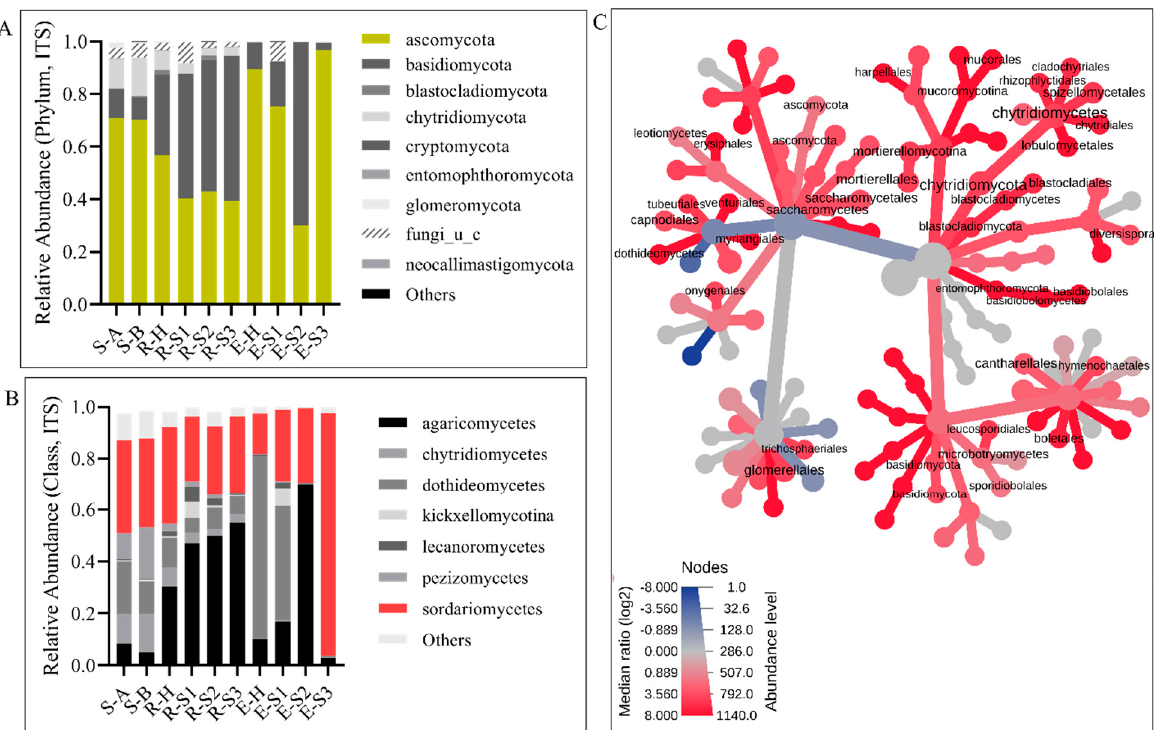
Figure 3. The effect of taproot decline disease on the soybean root mycobiome. ( A , B ) The bar graphs report the relative abundance of fungal taxa at the phylum ( A ) and class level ( B ) in bulk soil (S-A and S-B), rhizosphere (R-H, R-S1 to R-S3), and endosphere (E-H and E-S1 to E-S3) mycobiomes of healthy and TRD-symptomatic soybean. Only taxa with the highest abundance are shown. ( C ) Heat tree visualization of taxonomic differences between rhizosphere and endosphere mycobiomes. Blue and red indicate that corresponding taxa are lower and higher in the rhizosphere compared with the endosphere. The color gradient and the size of the node, edge, and label are based on the log 2 ratio of median abundance.